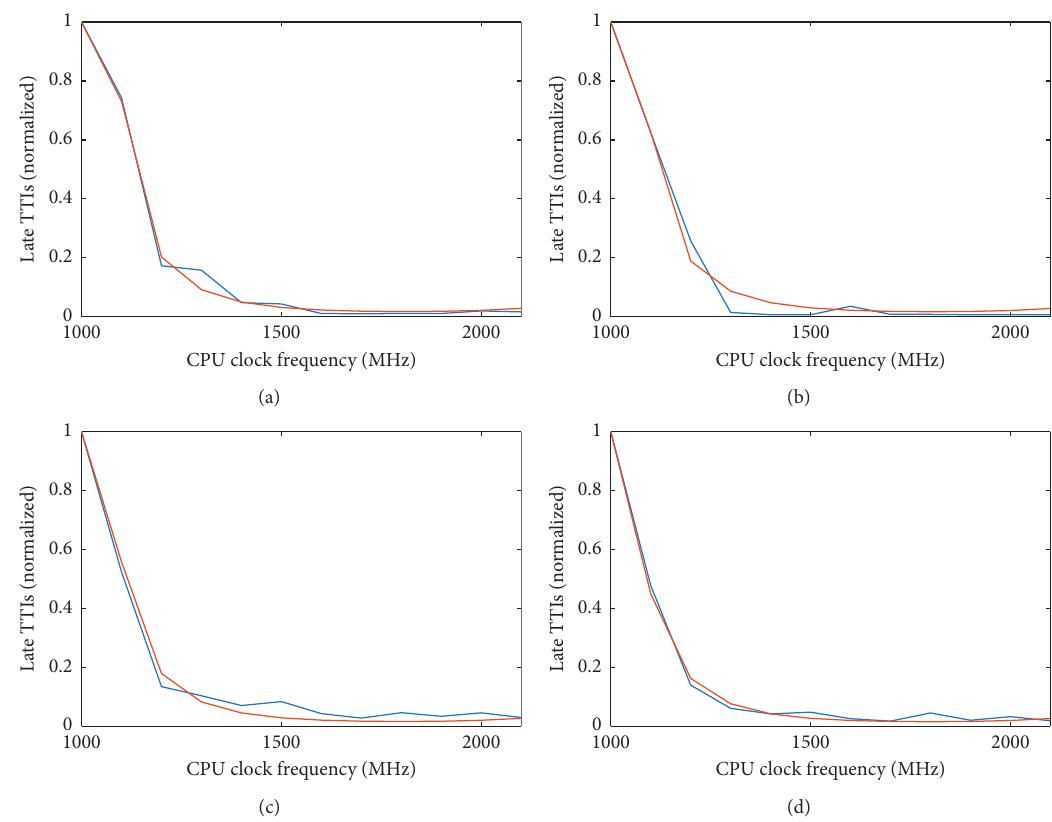
. (a) 5MHz bandwidth. (b) 10MHz bandwidth. (c) 15MHz bandwidth. m